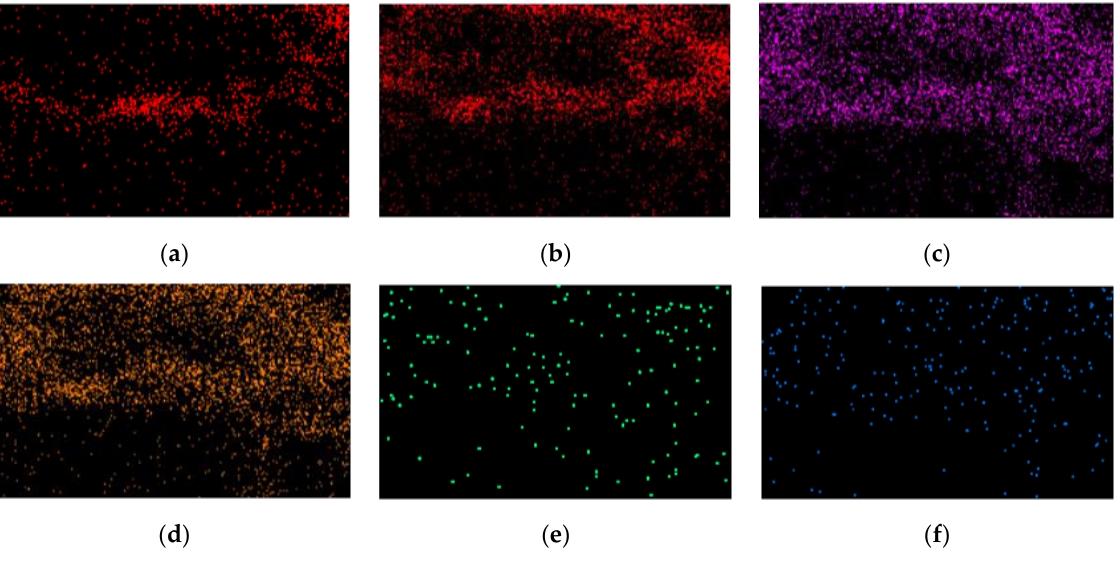
Figure 5. Distribution map of main elements in gangue samples. ( a ) Carbonel element; ( b ) Oxygen element; ( c ) Aluminum element; ( d ) Silicon element; ( e ) Kalium element; ( f ) Phosphorus element.